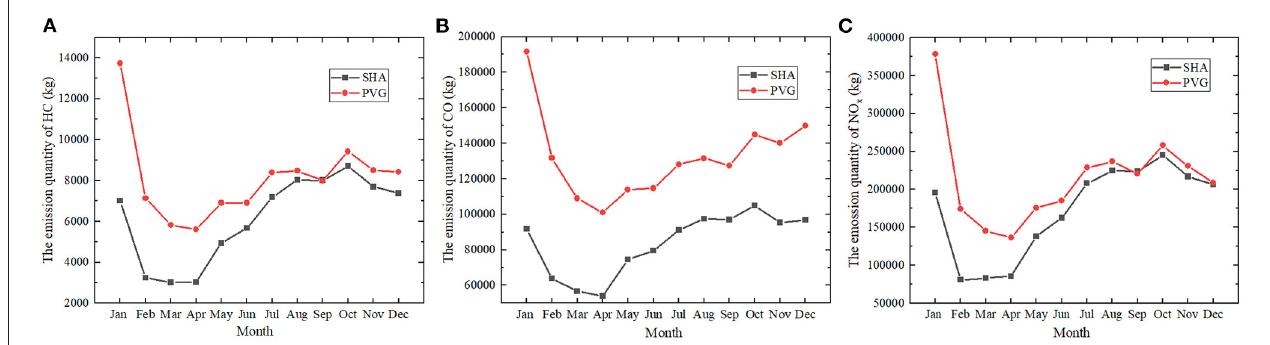
FIGURE 2 | The monthly variation of the air pollutants at 2 airports (i.e., PVG amd SHA) in Shanghai, 2020. (A) The emission quantity of HC in kilograms (B) The emission quantity of CO in kilograms (C) The emission quantity of NO x in kilograms. PVG, Shanghai Pudong Airport; SHA, Shanghai Hongqiao